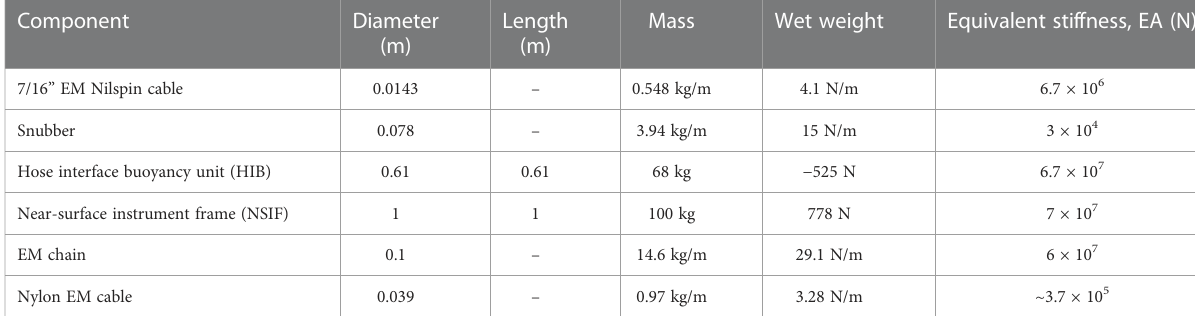
TABLE 2 Properties of mooring cable